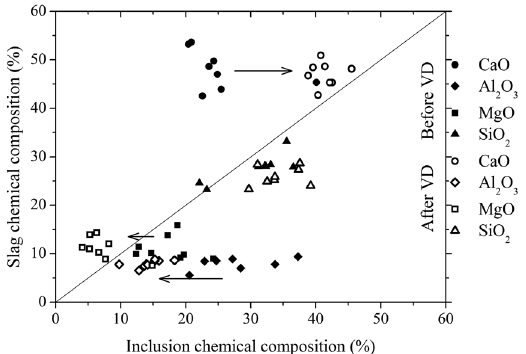
Figure 6. Chemical composition and diameter range of inclusions O , MgO and SiO content. (a) before and (b) after vacuum treatment. 2 3 2